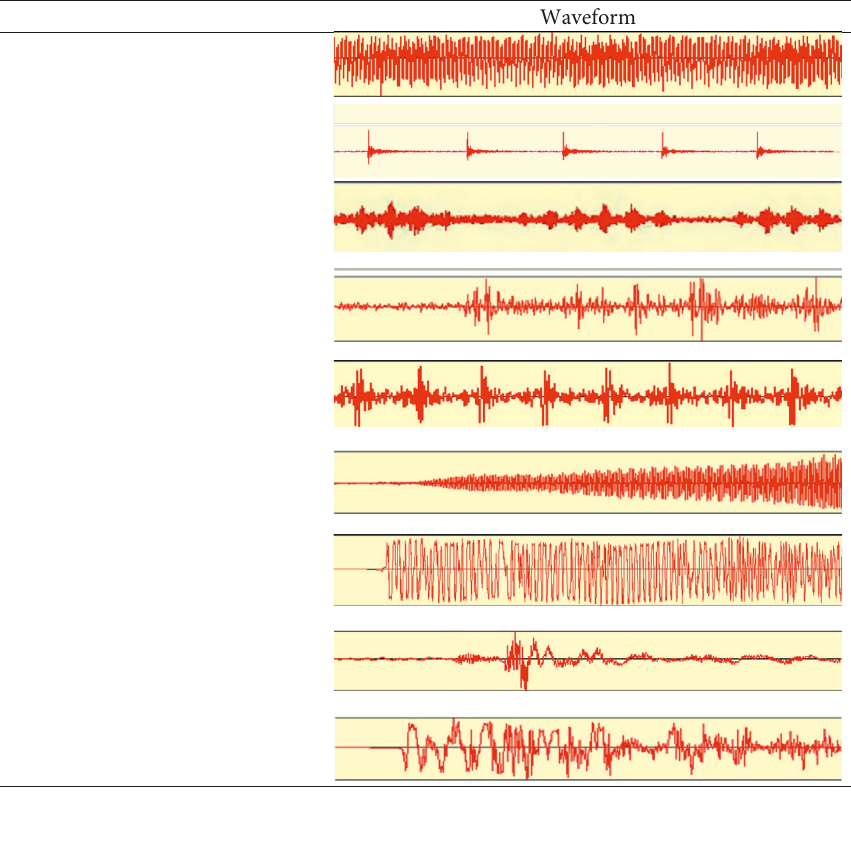
Table 2: Acoustic waveforms encountered at the Jinping deep-buried tunnels